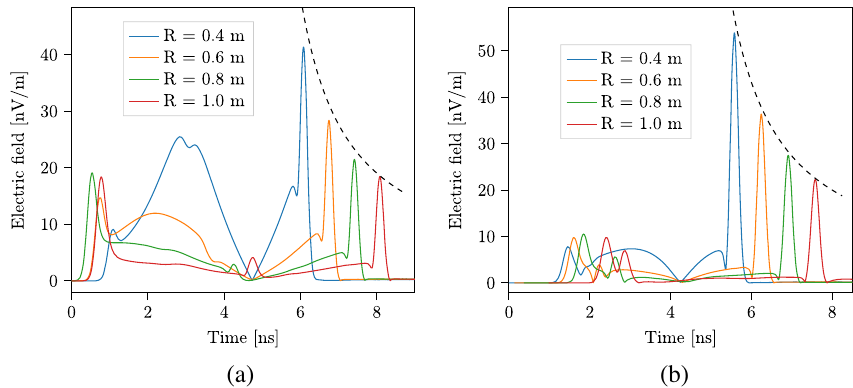
FIG. 10. Absolute TR electric fields at four monitors placed at incremental distances from the target at (a) 45° and (b) 80° angles for β ¼ 0 . 6 . The dashed line represents 1 =r